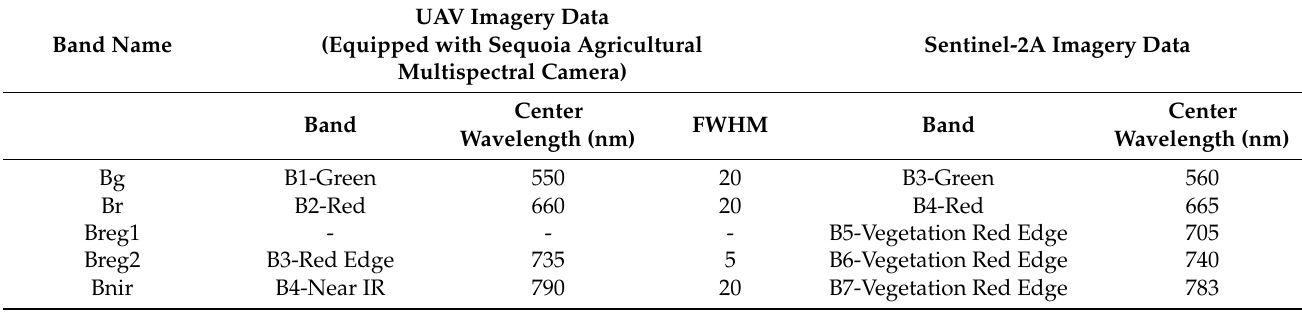
Table 1. The corresponding relationship of data between Sentinel-2A imagery and UAV